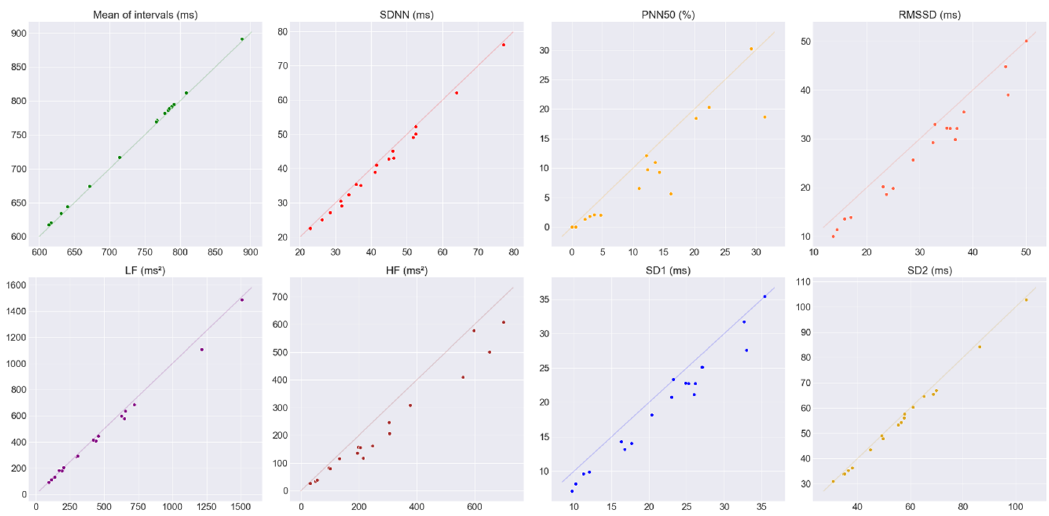
Figure 6. Pairs of HRV metrics obtained during the SCWT plotted against a 45º line (that would represent a perfect agreement). The HRV metrics obtained from the James One are represented on the x -axis and the ones from the Polar H10 on the y -axis.